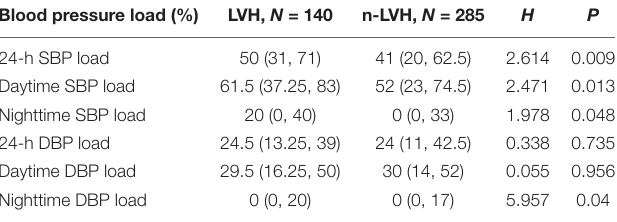
TABLE 3 | The association of blood pressure load with left ventricular hypertrophy.